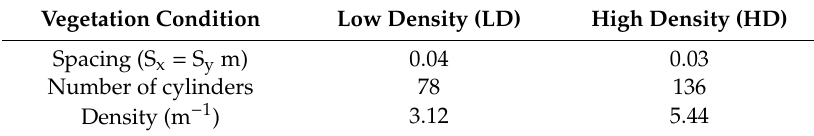
Table 1. Experimental parameters for vegetation patch.